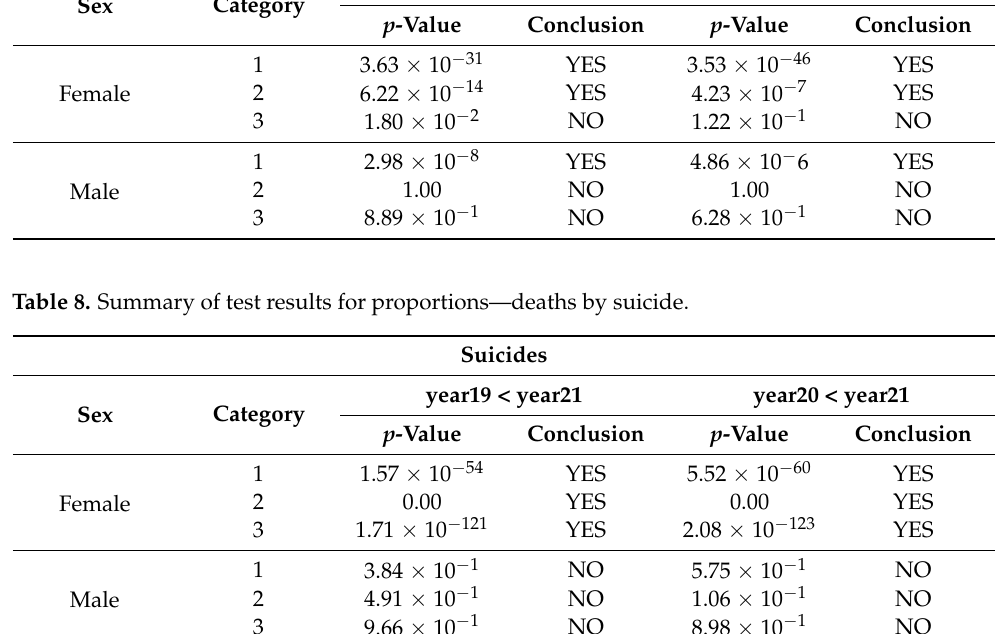
Figure 9. The number of suicides per 100,000 men.